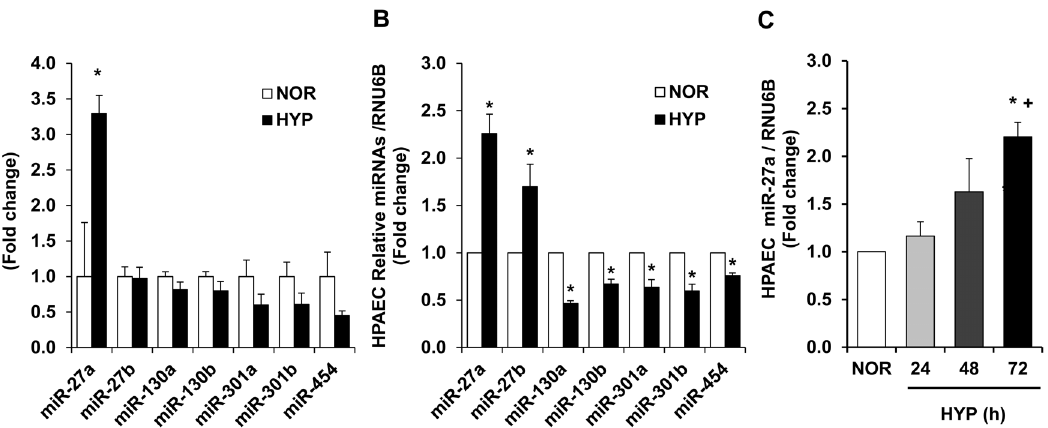
Figure 1. microRNA levels in hypoxia-exposed C57BL/6 mice and HPAECs. A. C57BL/6 mice were exposed to normoxia (NOR, 21% O 2 ) or hypoxia (HYP, 10% O 2 ) for 3-wks. qRT-PCR was performed on lung tissue for selected miRNAs predicted to regulate PPAR c expression. miRNA levels are expressed relatives to RNU6B and normalized to control values. *p , 0.05 vs. NOR, n=6–7. B. HPAEC were exposed to NOR or HYP (1% O 2 ) in vitro for 72 h. n=3, * p , 0.05 vs. NOR. C. HPAECs were also examined following exposure to hypoxia for 0, 24, 48, or 72 h. HPAEC miRNA was isolated and subjected to qRT-PCR analysis along with RNU6B. Each bar represents the mean 6 SE miR-27a relative to RNU6B expressed as fold change vs. SCR. n=3, *p , 0.05 vs. NOR. + p , 0.05 vs. 24 h.